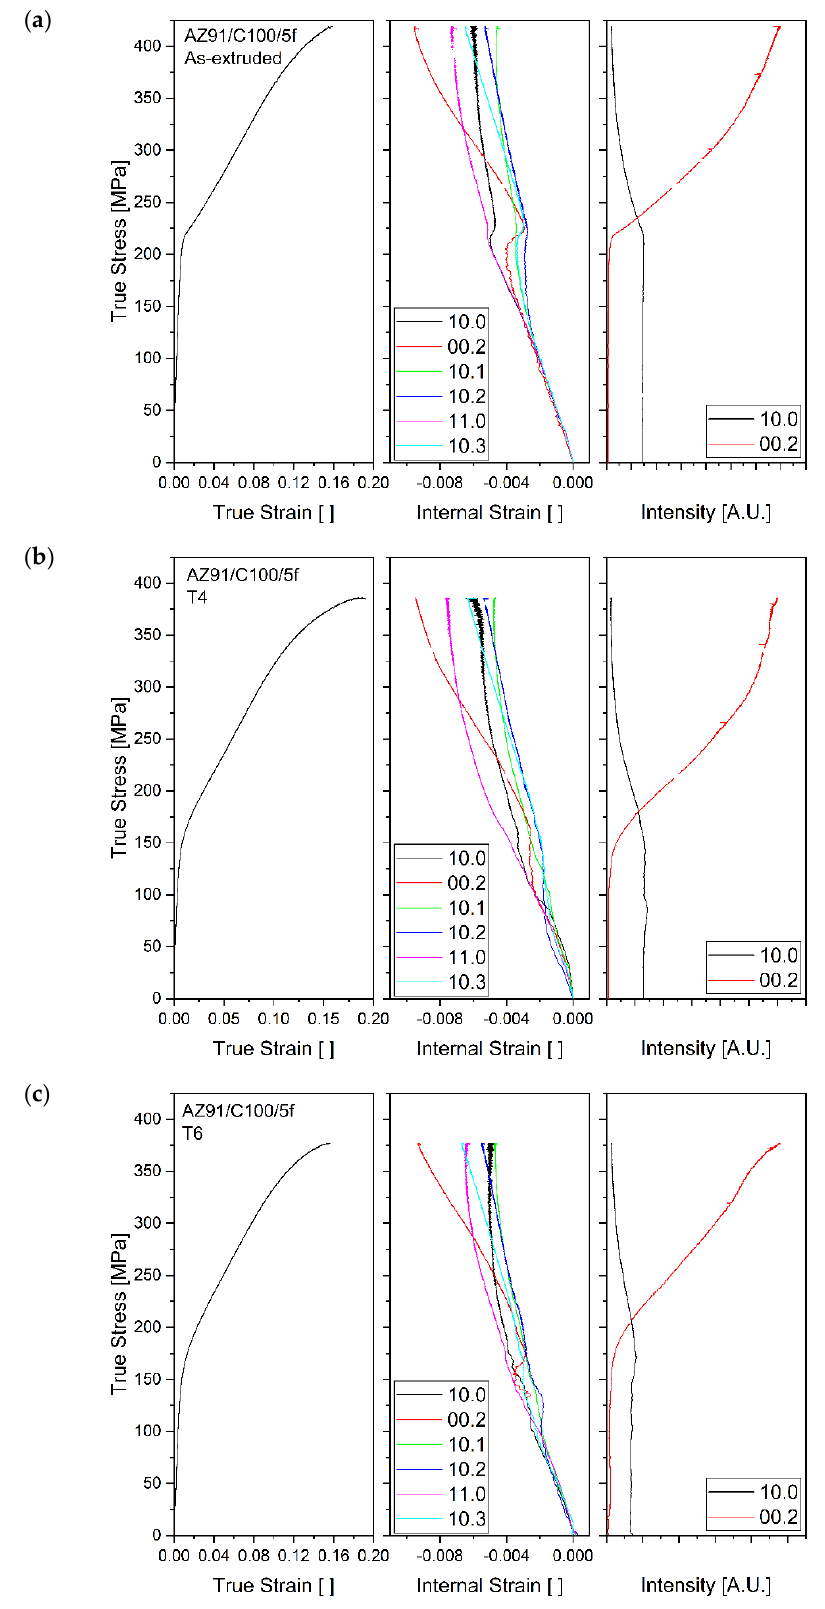
Figure 4. Plots showing macroscopic true strain (left), strain on lattice planes (centre), and intensity (right) against true stress for ( a ) AZ91/C100/5f as extruded; ( b ) AZ91/C100/5f T4; ( c ) AZ91/C100/5f